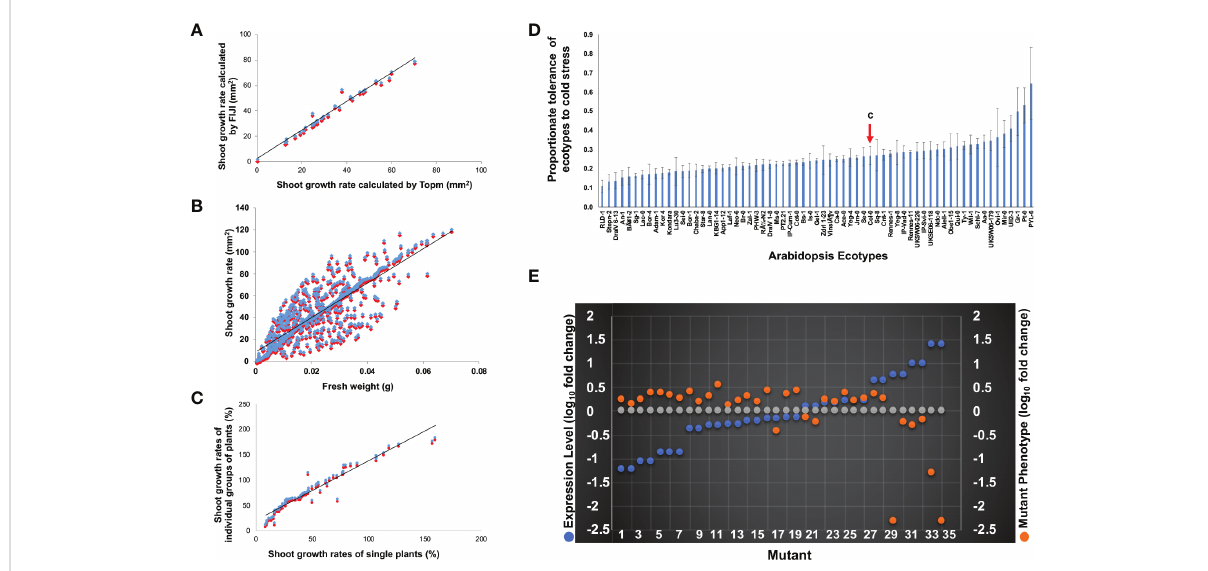
FIGURE 2 Phenotypic analyses of the chilling tolerance trait in Arabidopsis. (A) Scatterplots demonstrating the relationships between the shoot surface area calculated by FIJI (blue) and Top.m (red) programs. The fi tted line displays statistically signi fi cant correlations ( r = 0.99). (B) Relationships between the digital shoot surface area (sq. mm) calculated by Top.m (blue spot) and fresh weight (g) of shoots. The scatterplot showed a positive association ( r = 0.83) between the digital shoot surface area (sq. mm) calculated by Top.m (blue) and fresh weight (g) of shoots